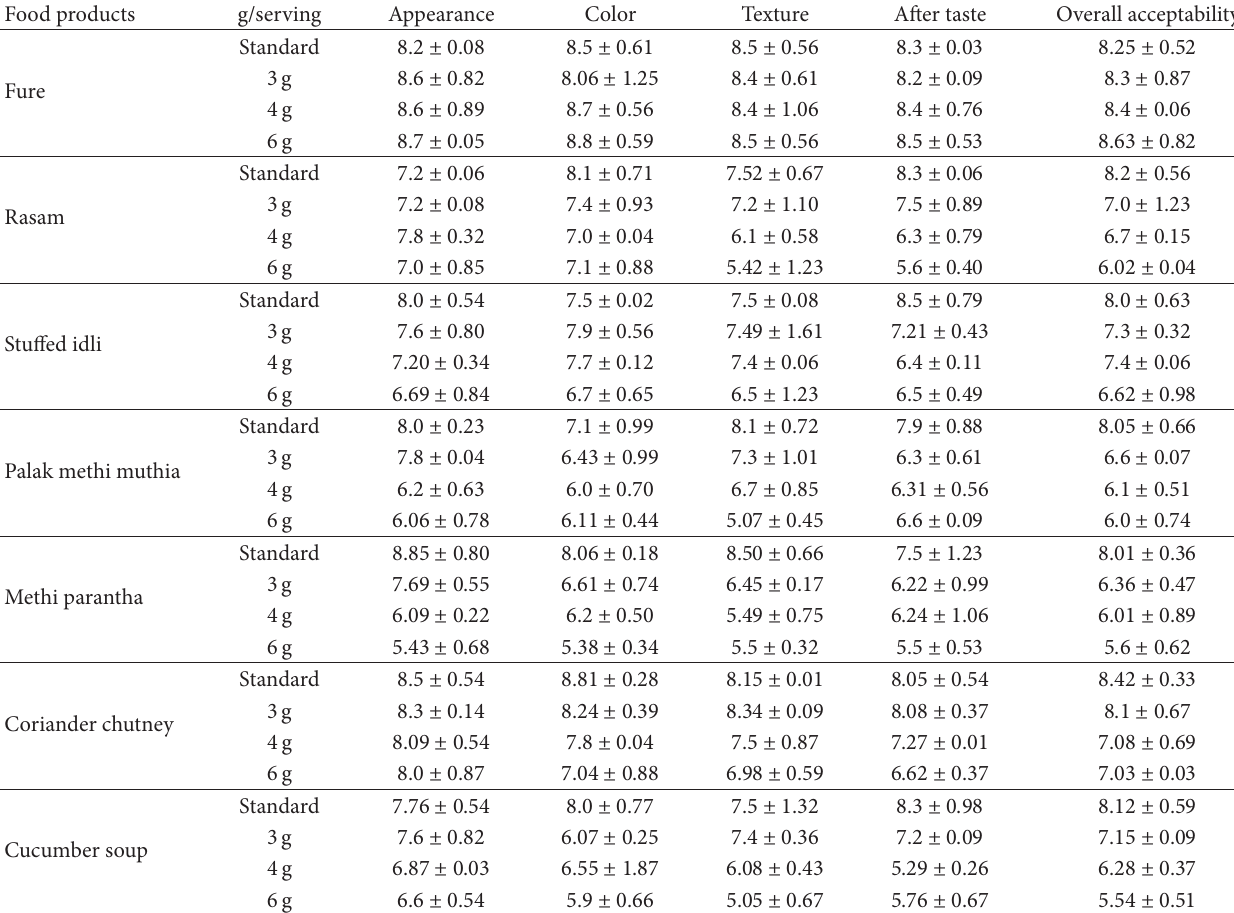
Table 2: Organoleptic evaluation of food products developed by incorporation of Catharanthus roseus fresh leaves. Food products